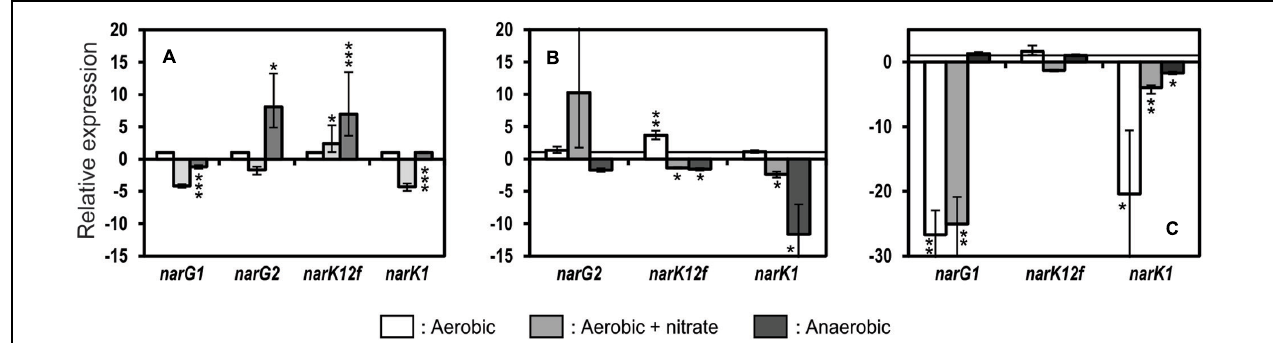
FIGURE 5 | Relative expressions of narG1 , narG2 , narK12f , and narK1 . Strain JAM1 (A) , JAM1 (cid:2) narG1 (B) and JAM1 (cid:2) narG2 (C ) were cultured in triplicate of the same inoculum under aerobic conditions with or without nitrate and under anaerobic conditions with 40 mM nitrate. Biomass was collected during the exponential phase, and total RNA was extracted for RT-qPCR assays. (A) Changes in the levels of narG1 , narG2 , narK12f , and narK1 transcripts in strain JAM1 cultures under aerobic with nitrate and anaerobic conditions were calculated relative to their expressions under aerobic conditions without nitrate (set to one, white column). (B,C) Changes in the levels of narG1 , narG2 , narK12f , and narK1 transcripts in the JAM1 (cid:2) narG1 and JAM1 (cid:2) narG2 cultures under the three conditions were calculated relative to their expressions in the strain JAM1 cultures under the respective conditions. Error bar represents standard deviation of triplicate values. ∗ 0.05 < P < 0.01; ∗∗ 0.01 < P < 0.001; ∗∗∗ P < <